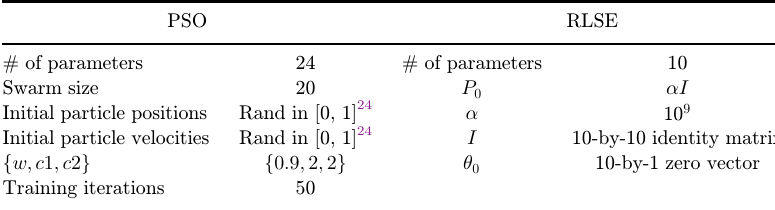
Table 2. Settings for the PSO – RLSE in experiment.